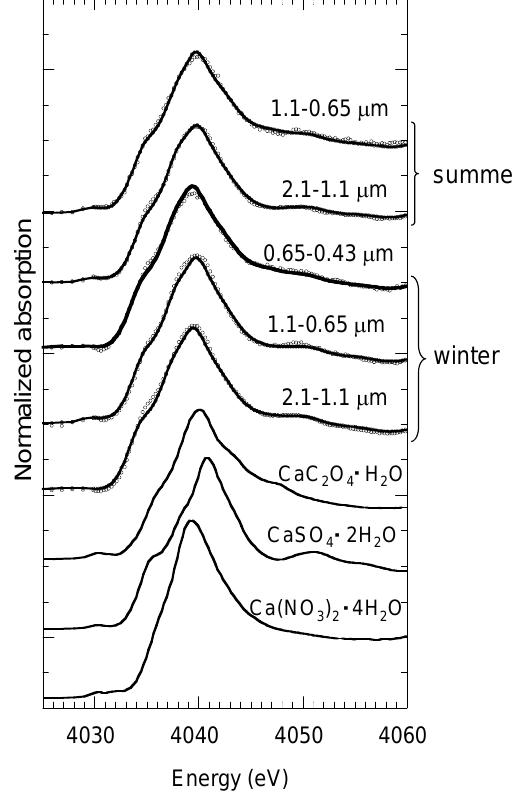
Fig. 4. Calcium K-edge XANES spectra (open circles=samples, lines=fitting) of finer particles during winter and summer at Tsukuba with those of the standard materials used for